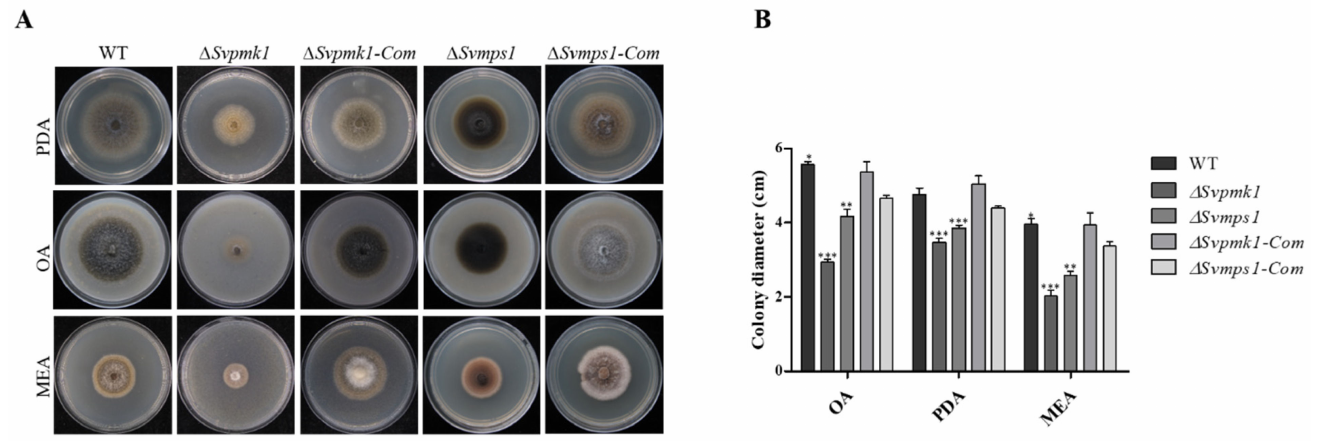
Figure 2. Roles of SvPmk1 and SvMps1 in the vegetative growth of S. versabilis. ( A ) Vegetative growth of the WT, mutants and complemented strains on PDA, OA and MEA media at 7 days post inoculation (dpi). ( B ) Analysis of the colony diameters of the various strains at 7 dpi. Error bar = standard deviation from mean of three independent replicates; * p < 0.1; ** p < 0.01; *** p <